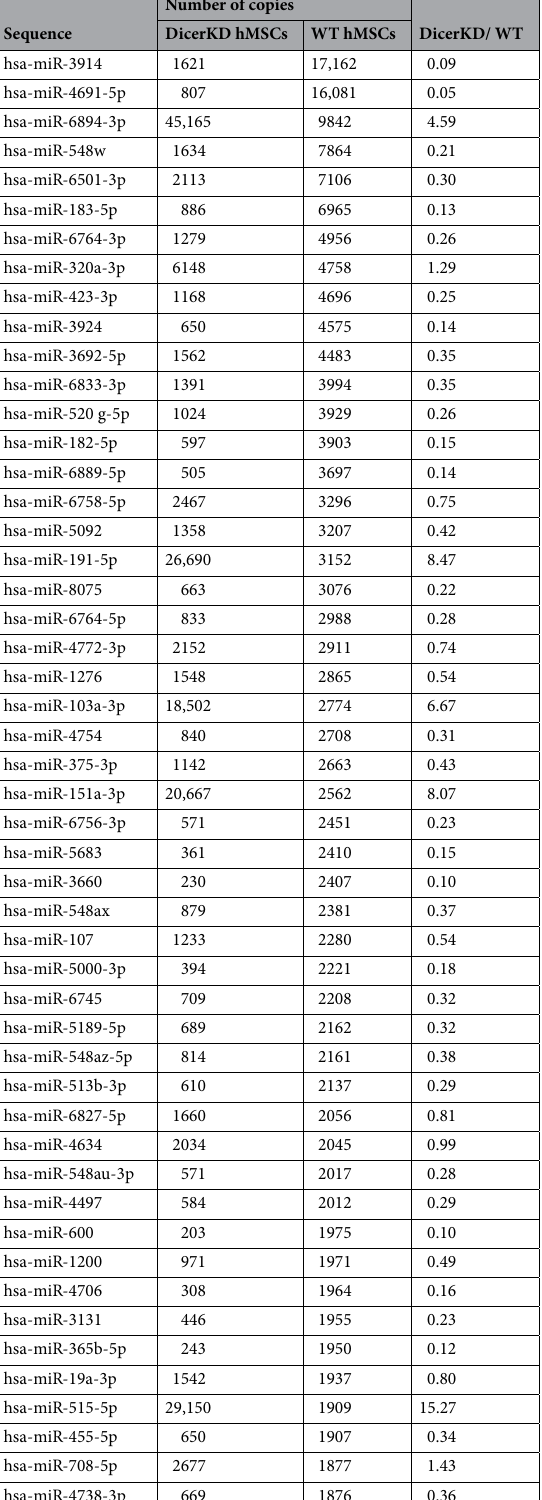
Table 1. Top 50 most abundant miRNAs in WT hMSCs and their expression in DicerKD